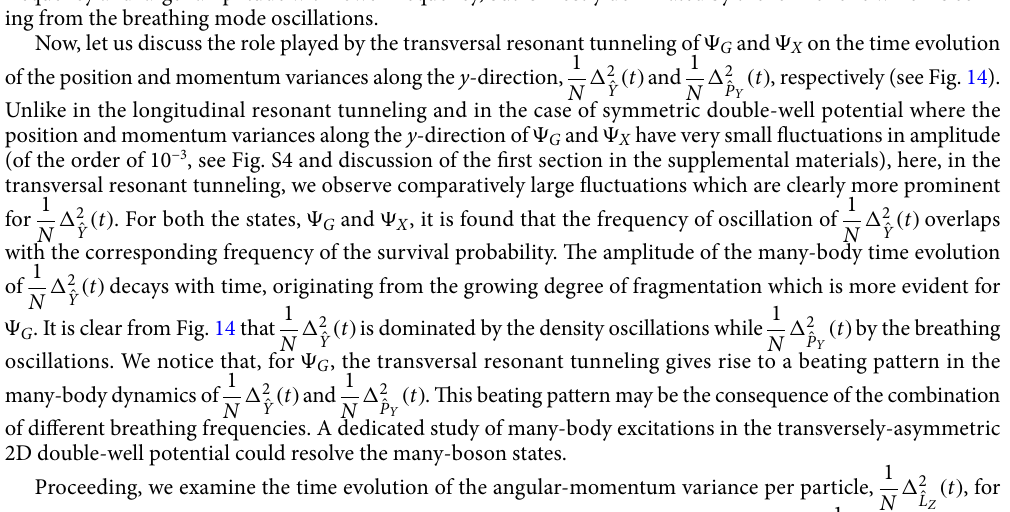
Figure 14. Time-dependent position and momentum variance per particle along the y -direction in a transversely-asymmetric 2D double-well potential for (cid:31) G (left column, ω n 0.18 ) under transversal resonant tunneling conditions. The number of bosons is N ω n = 0.01 π . M 1 signifies the mean-field results. The many-body dynamics are interaction parameter � = = 6 time-dependent orbitals. We show here dimensionless quantities. Color codes are computed with M = explained in each